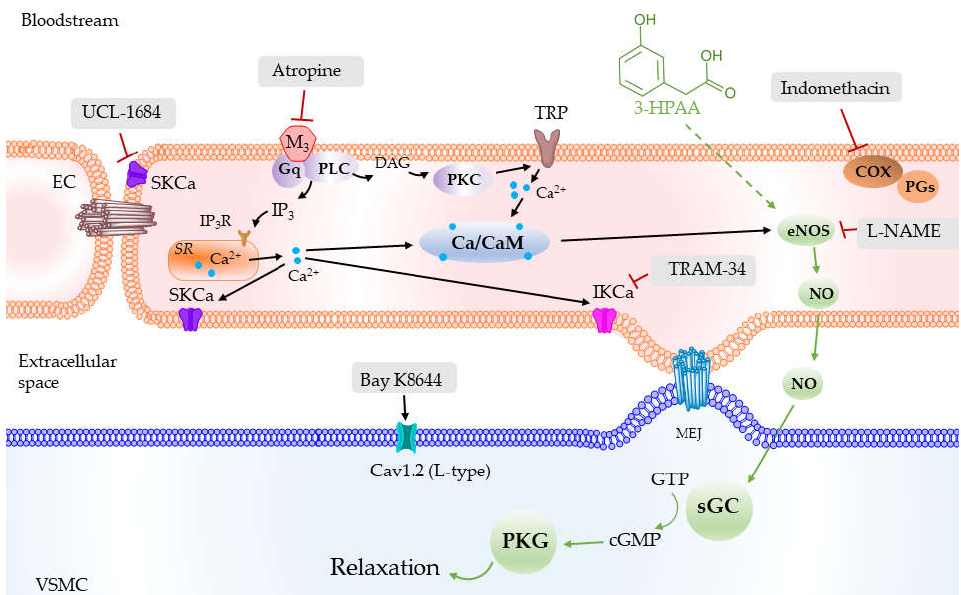
Figure 8. Schematic depiction of the possible mechanism of action of 3-hydroxyphenylacetic acid (3-HPAA) involving the production of NO in endothelial cells and activation of sGC in vascular smooth muscle cells (green arrows) and other pathways investigated in the current study. SKCa—small conductance Ca 2+ -activated K + channels; IKCa—intermediate conductance Ca 2+ -activated K + channels; M 3 —muscarinic receptor subtype M 3 ; PLC—phospholipase C; DAG—diacylglycerol;